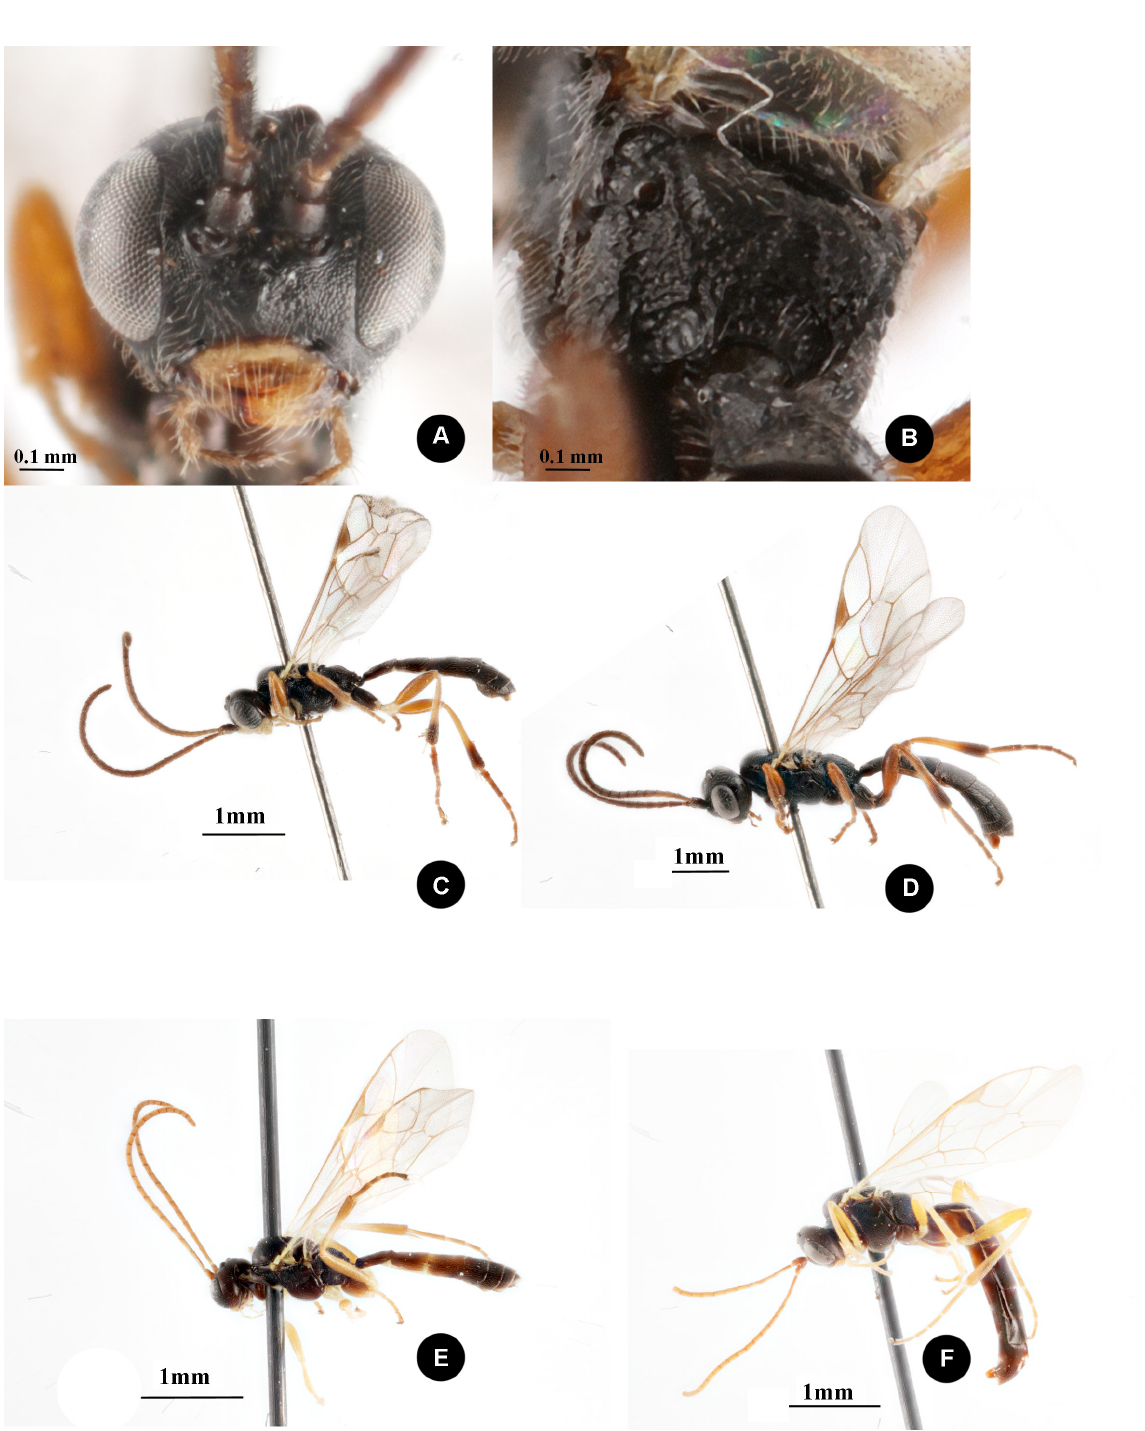
Fig. 1. A–D . Saotis brachycerus (Kasoparyan & Kopelke, 2009) comb. nov. A . Face. B . Propodeum. C . Habitus paratype, ♂ S. brachycerus (Kasoparyan & Kopelke, 2009). D . Habitus holotype,